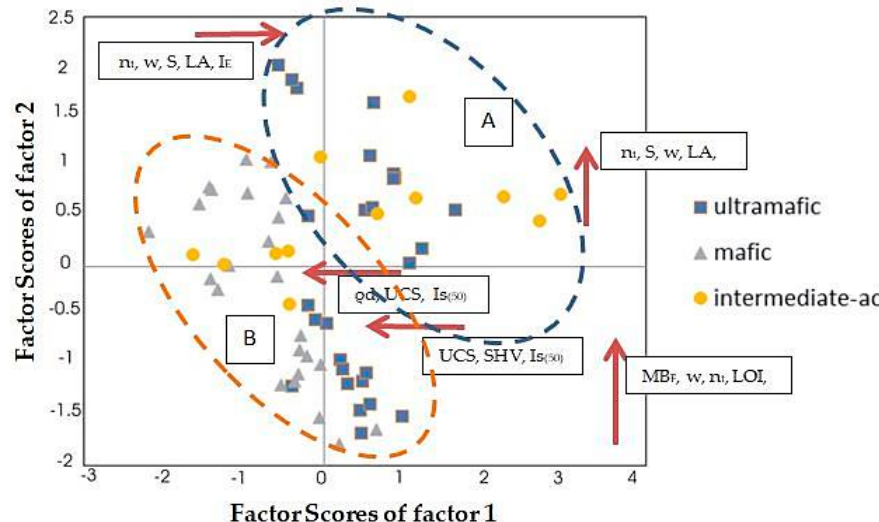
Figure 8. The factor scores of the first factor plotted against the factor scores of the second factor (R-mode factor analysis) were w = moisture content (%), n t = total porosity (%), ρ d = dry density (KN/m 3 ), I E = elongation index (%), LA = Los Angeles abrasion (%), UCS = uniaxial compressive strength (MPa), Is (50) = point load index (MPa), SHV = Schmidt hammer value, S = soundness test (%), MB F = methylene blue test (g/kg), and LOI = Loss on Ignition.